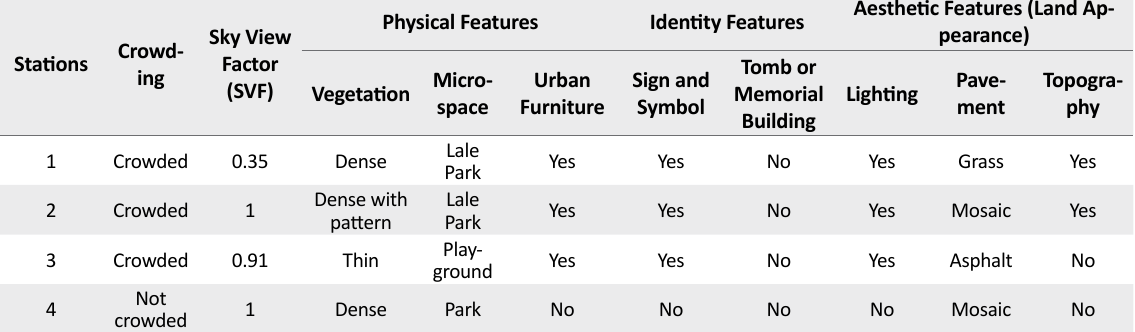
Table 1. Features and landscape structure in selected stations